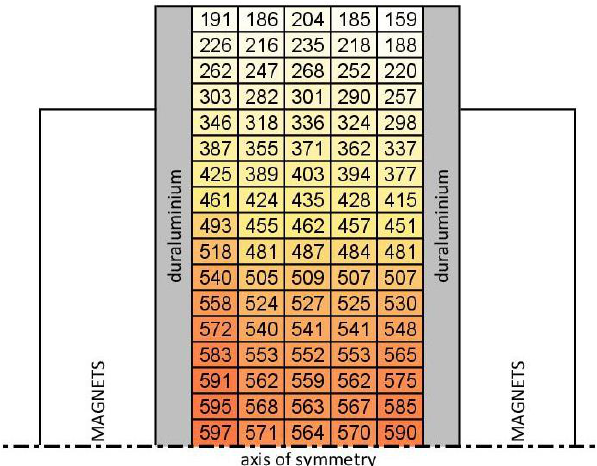
Figure 17. The results of induction distribution measurement in the machining gap [×10 −3 T]. The distance between magnets amounts to 33 mm.